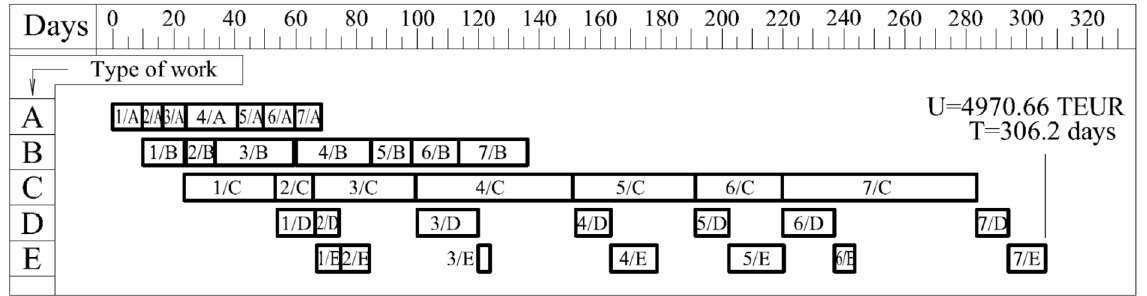
Figure 3. Permutation π 0 —construction project schedule considering LAF.